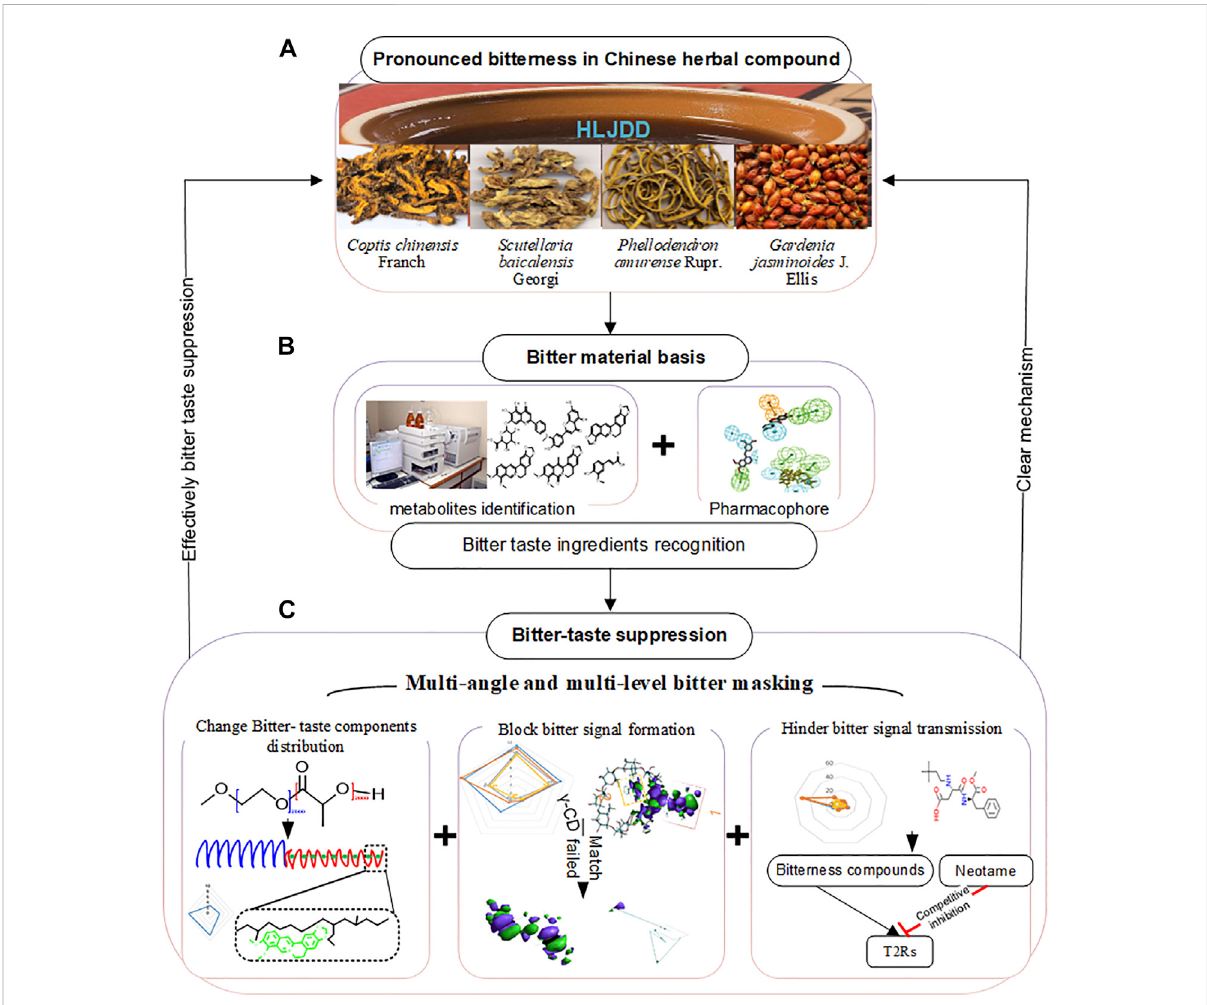
FIGURE 1 Graphic abstract. (A) HLJDD comprises Coptis chinensis Franch, Scutellaria baicalensis Georgi, Phellodendron amurense Rupr., and Gardenia jasminoides J. Ellis. It has a strong bitter taste. (B) UHPLC-MS/MS was used to identify the metabolites in HLJDD, and pharmacophores were used to recognize bitterness metabolites. (C) Multi-angle and multilevel bitter masking strategy with the amphiphilic block polymer, inclusion complex, and sweetener were applied to bitter-taste suppression of HLJDD. This new strategy achieved signi fi cant bitterness suppression and revealed the mechanism of bitter taste masking by combining the virtual analysis and experiment